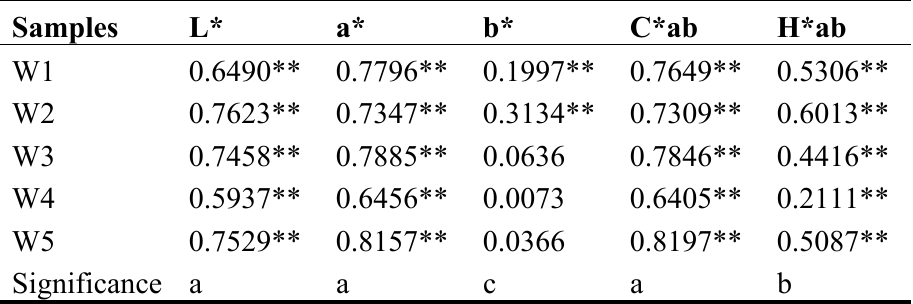
Table 2. Determination coefficients (R 2 ) of regression equations from anthocyanins vs. CIELAB values estimated by PCR in five wine